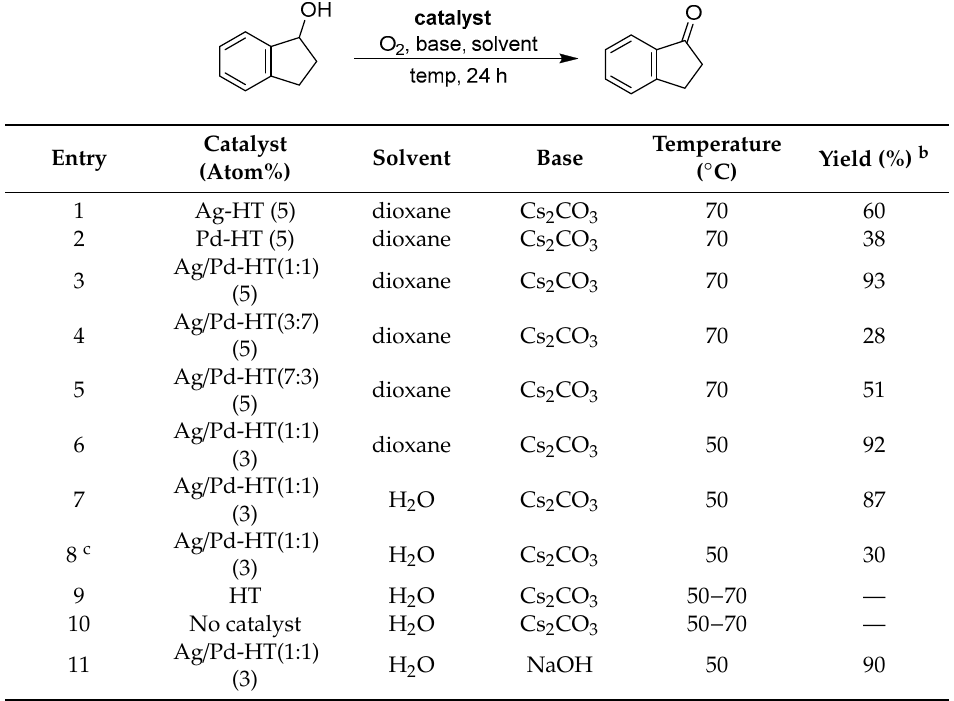
Table 1. Catalyst screening and optimization of reaction conditions for oxidation of 1-indanol a